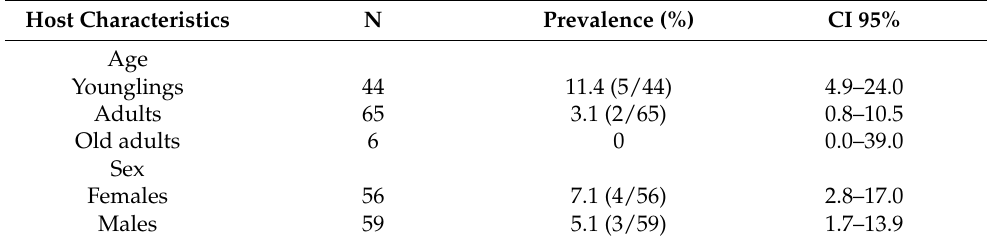
Table 3. Seroprevalence of Trichinella spp. antibodies in wild boars according to age and sex. Host